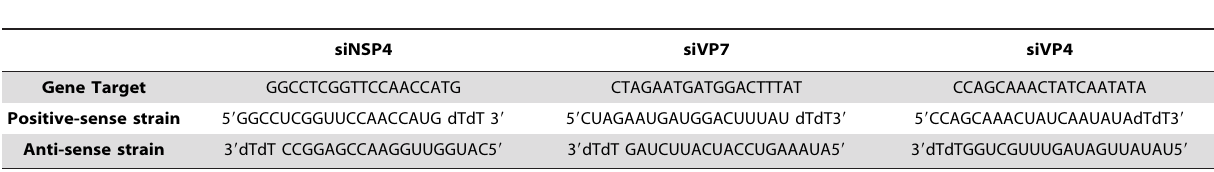
Table 2. siRNA targets and sequences against NSP4, VP7 and VP4.